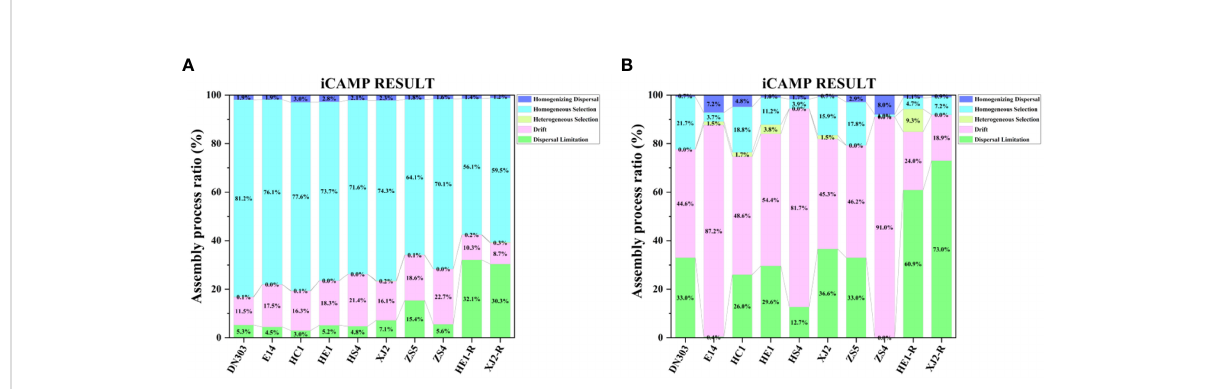
FIGURE 5 Ecological processes of microbial community assembly. (A) The bacterial community, (B) the fungal community. Dongnong303 (DN303), E14 (E14), Huacai1 (HC1), Huaen1 (HE1), Huashu4 (HS4), Xingjia2 (XJ2), Zhongshu5 (ZS5) and Zhongshu4 (ZS4) were planted under continuous cropping regime. Huaen1 (HE1-R) and Xingjia2 (XJ2-R) were planted under rice-potato rotation regime. Different colors represent the different assembly